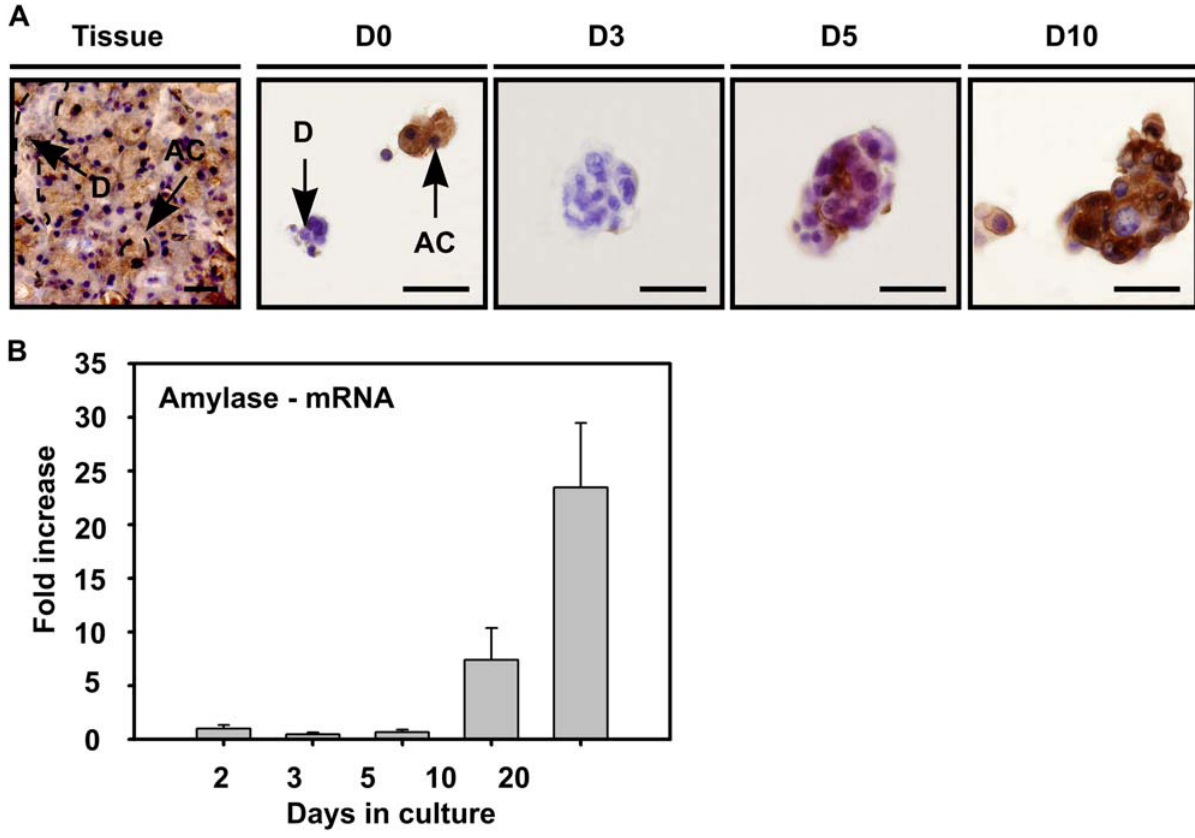
Figure 3. Differentiation of salisphere into acinar cells. (A) Amylase expressing cells (AC) in submandibular gland tissue (Tissue) were also present at the onset of culture (A-D0), and were visualized in the sphere at the onset of day 5 (A-D5), whereas granulae-containing spheres appeared in culture at later time-points (A-D10). Antibody labeling is shown in brown, nuclei in blue. Scale bar=50 m m. (D=duct cells, AC=acinar cells, D0–3– 5–10 represent days in culture). (B) Real time RT-PCR confirmed the enhanced expression of amylase during in vitro culturing and differentiation. Error bars represent SEM ( N =2). Amylase mRNA expression levels at 2 days of culture were normalized to one.